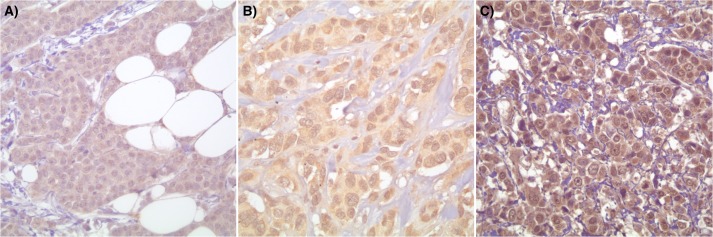
HIF-1αexpression in breast ductal carcinoma cells with negative (A) and weak (1+ and 2+) expression (B & C) (400x magnification).